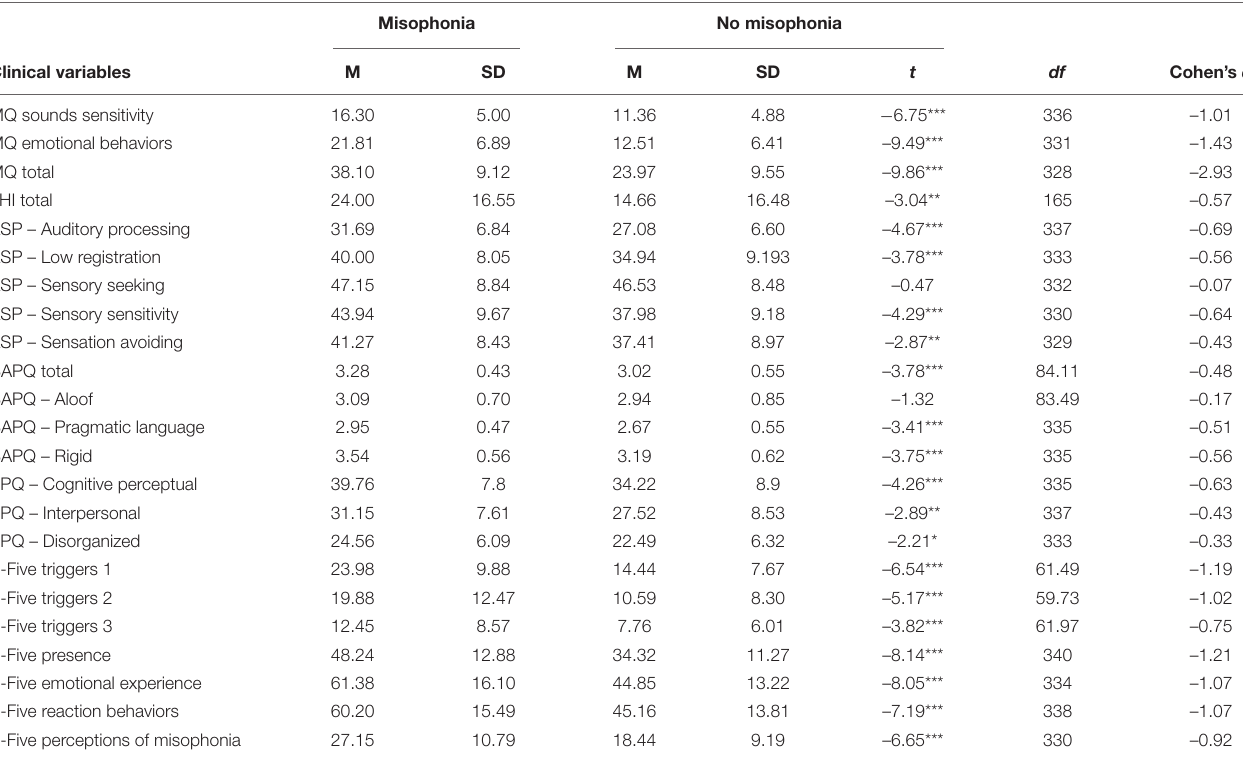
TABLE 2 | Results of independent samples t -tests comparing misophonia groups on scored clinical